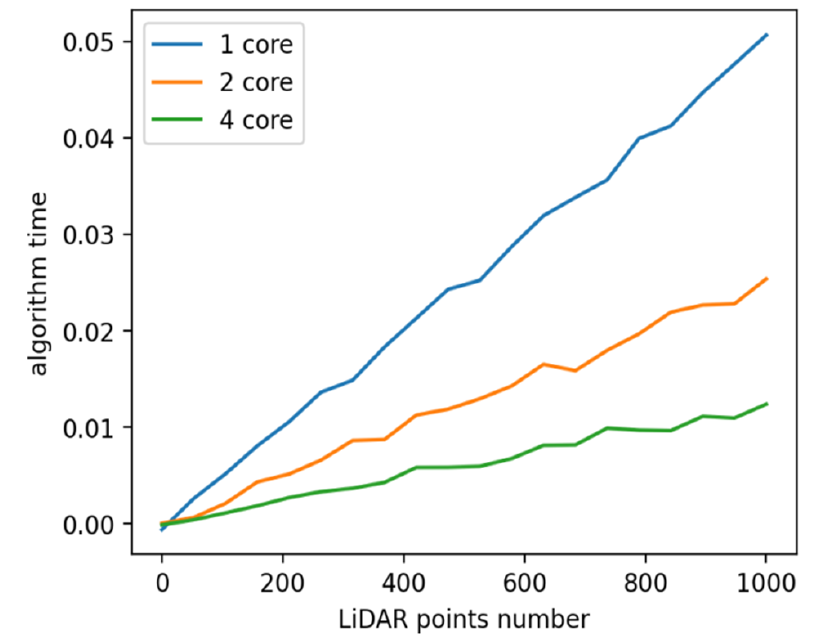
Figure 5. Dependence of the algorithm operation time on the number of points with a different number of processor cores.